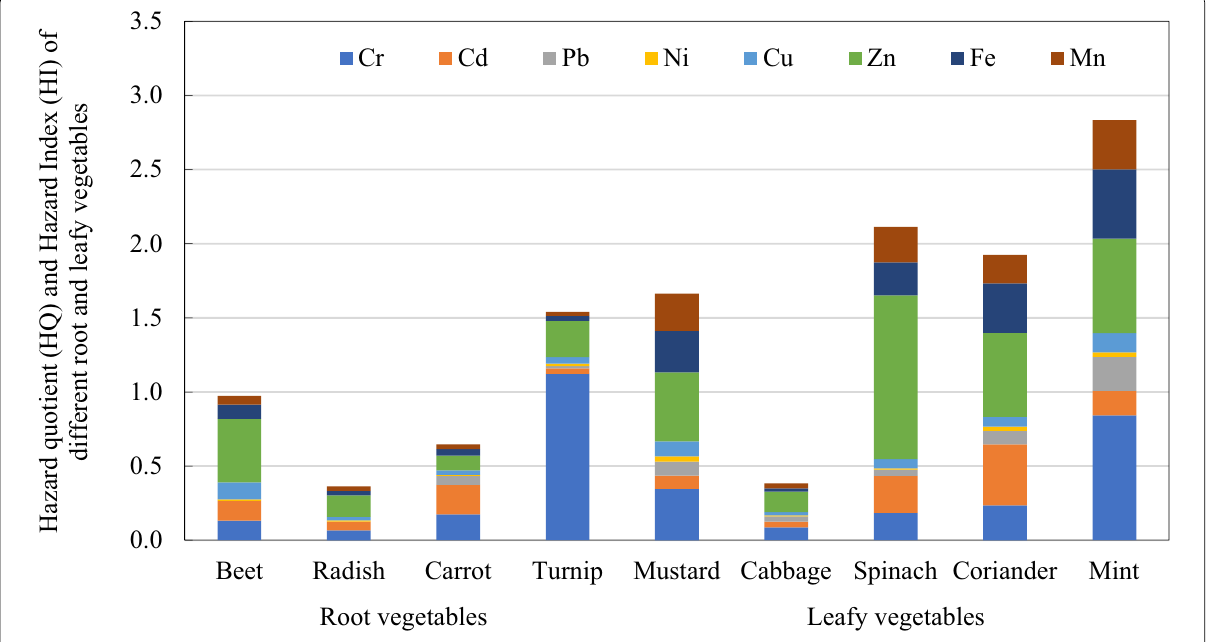
Fig. 2 Hazard quotient (HQ) and Hazard Index (HI) of different vegetable